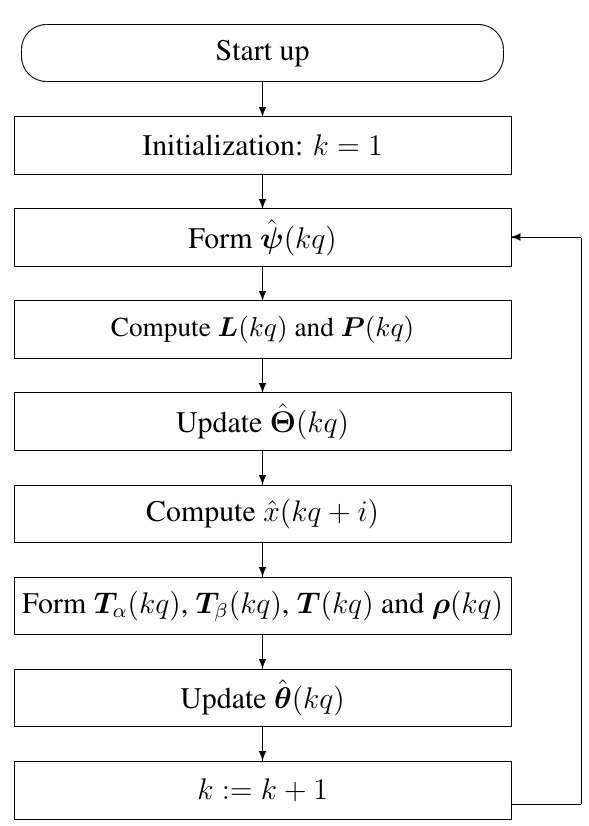
Figure 3. The flowchart for computing the estimates ˆ Θ ( kq ) and ˆ θ ( kq )